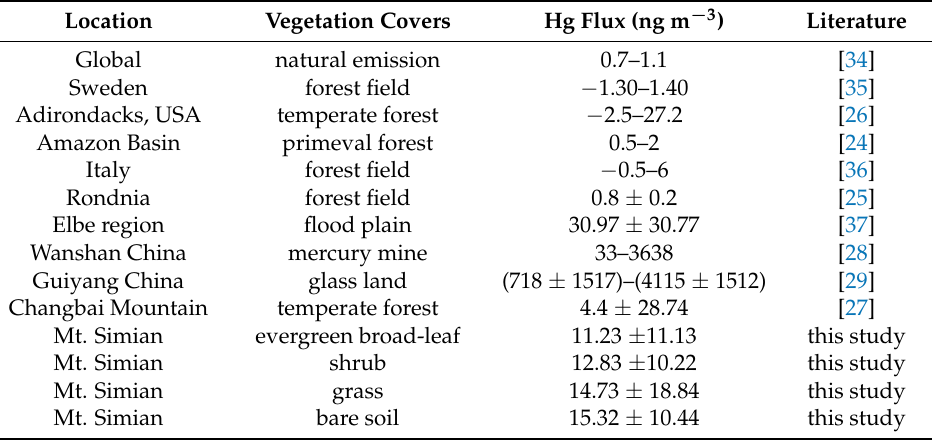
Table 2. The GEM fluxes at the soil–air interface reported in the